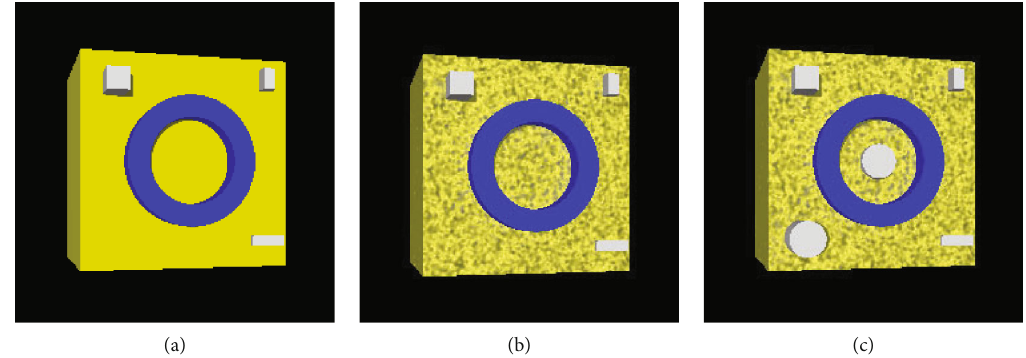
Figure 4: Schematic diagram of three di ff erent satellite models: (a) no texture with 3 components, (b) rough textures with 3 components, and (c) rough textures with 5